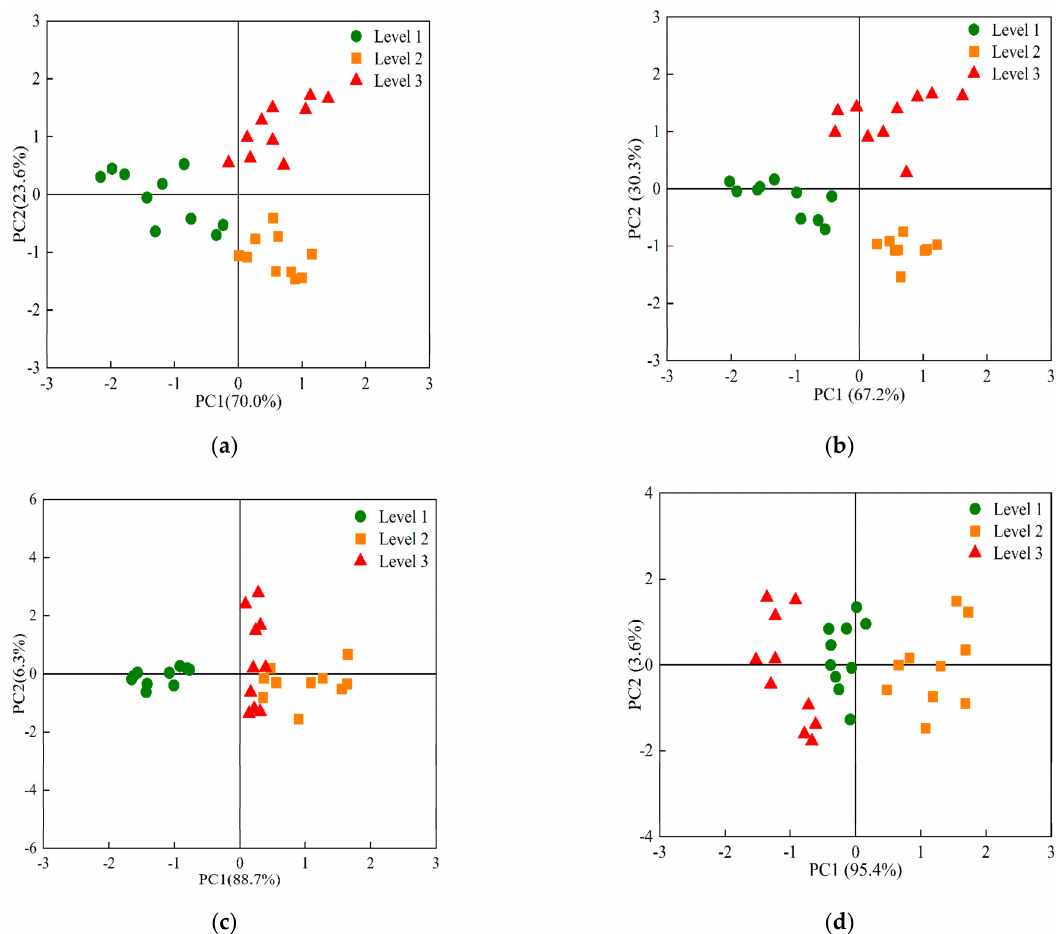
Figure 5. PCA score plots of cherry tomatoes with different freshness based on E-nose data at 0 ( a ), 4 ( b ), 10 ( c ) and 25 ◦ C ( d ). Note: Level 1: fresh fruit, Level 2: second-fresh fruit, Level 3: corrupt